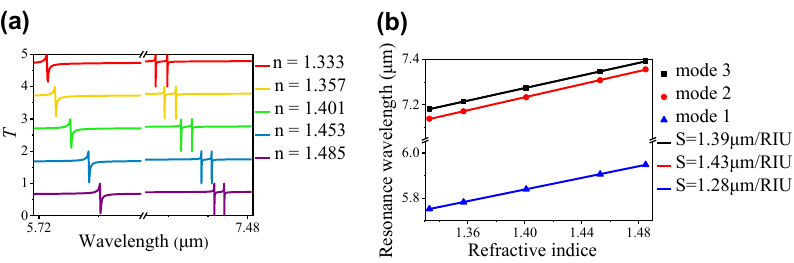
Table 1: Comparison of the proposed refractive index sensors with recent work in the infrared